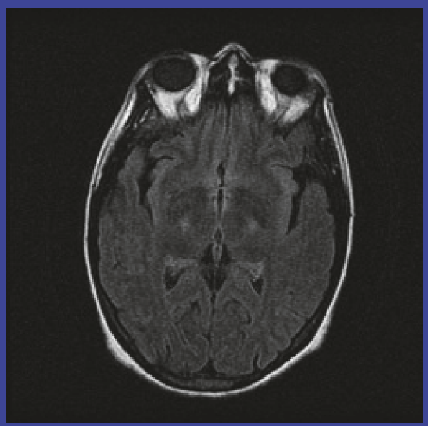
Figure 1: Axial brain MRI, FLAIR sequence, showing bilateral hyperintensities of the basal ganglia prior to transplantation.